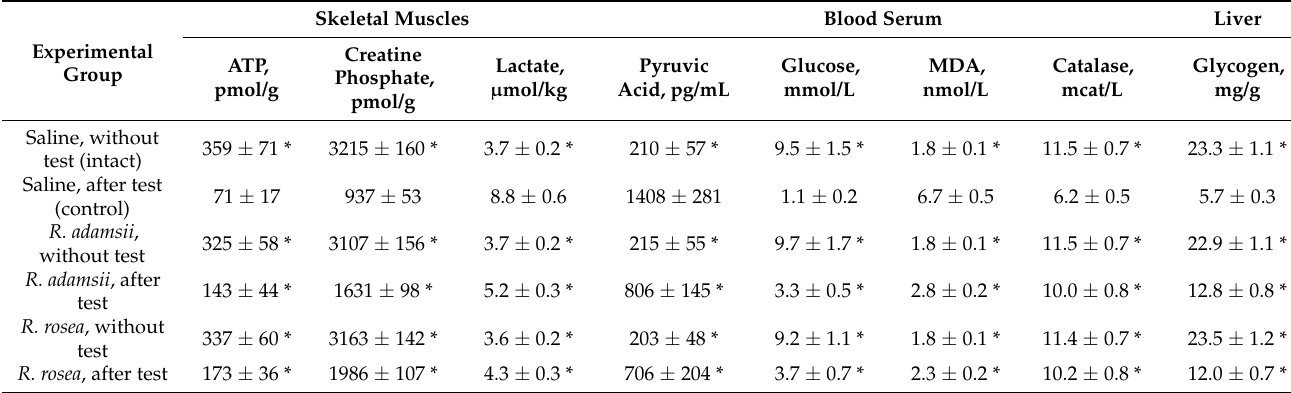
Table 6. Influence of R. adamsii leaf extract (July sample, dose 50 mg/kg) and R. rosea extract (dose 50 mg/kg) on biochemical parameters of the skeletal muscles, blood serum, and liver of mice after the two-step swimming test. Skeletal Muscles Experimental Group Saline, without test